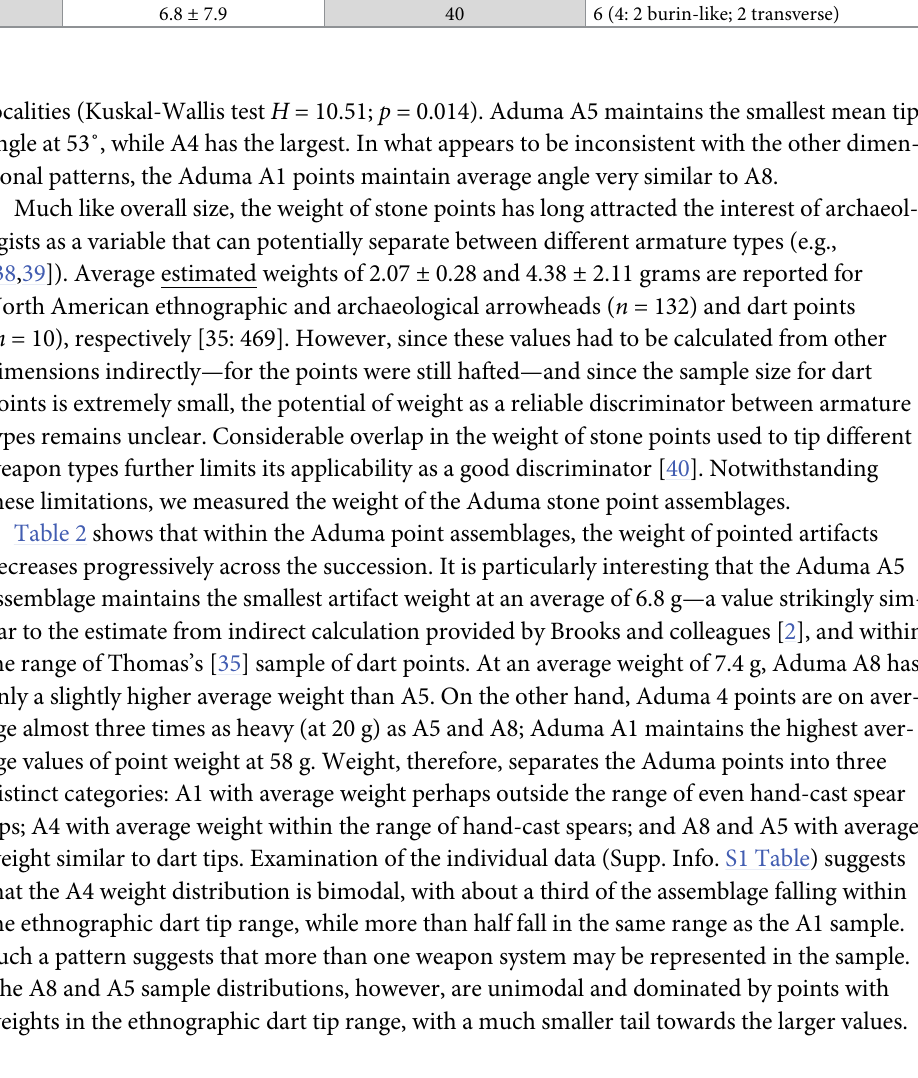
Sample ( n ) Aduma A1 ( 18